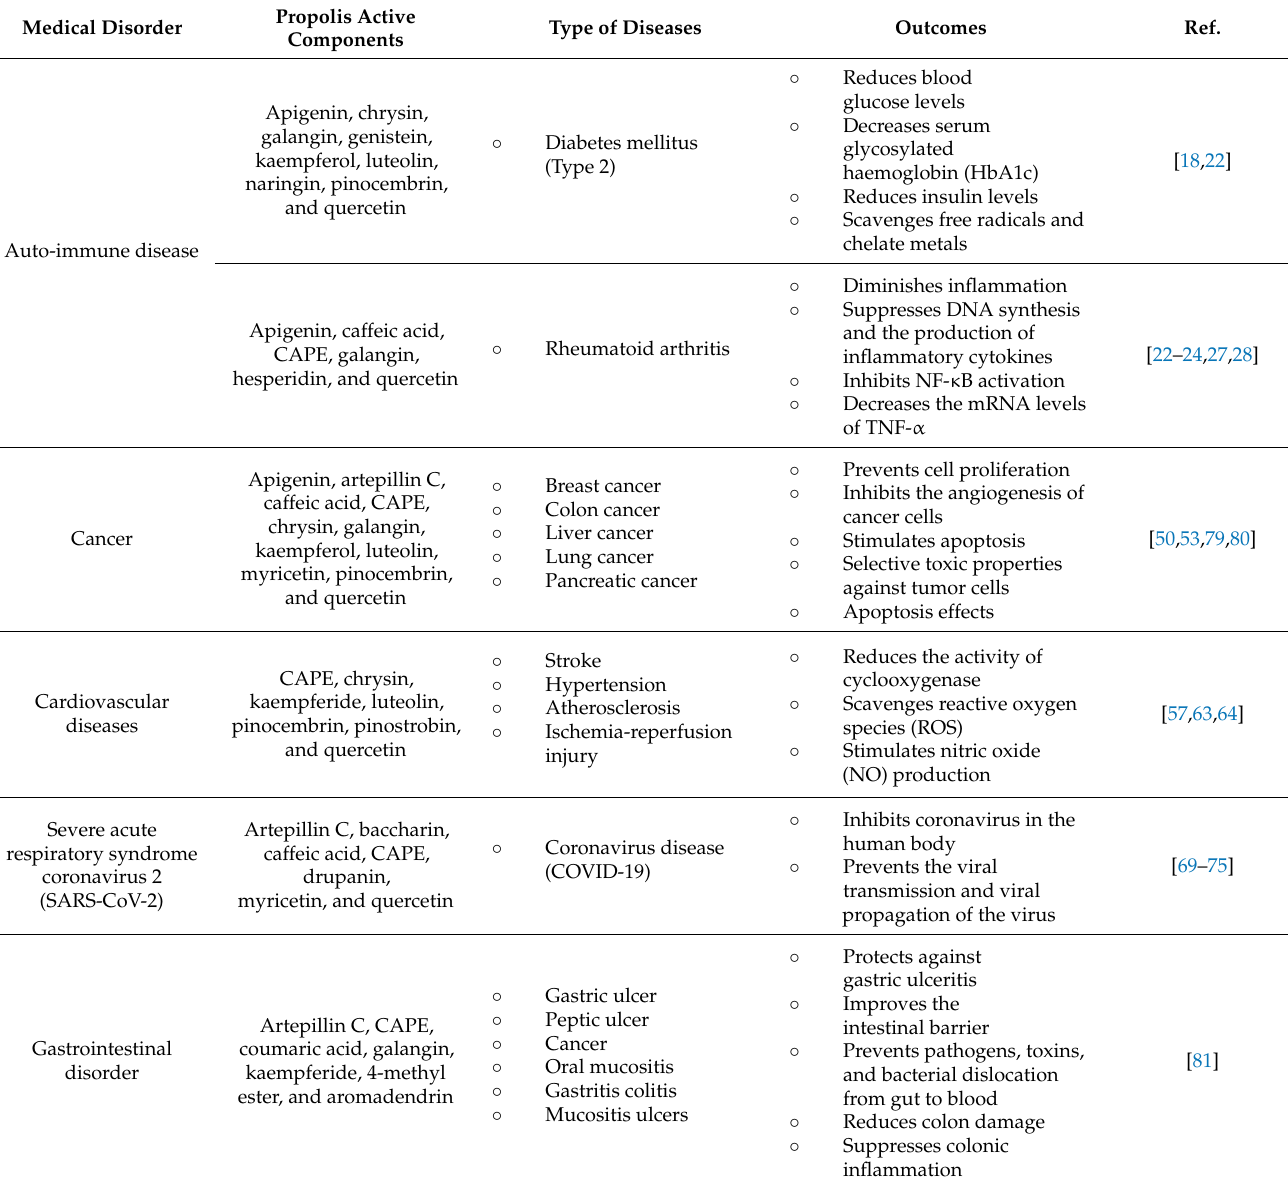
Table 2. Active components of propolis and their outcome effects on various medical conditions and